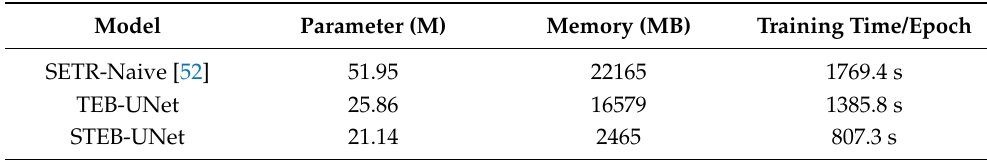
Table 5. Data statistics in training of different networks, where batch size is set to one, the size of input image is 128 × 128, and the loss function is set to BCE loss. Model Parameter (M) Memory